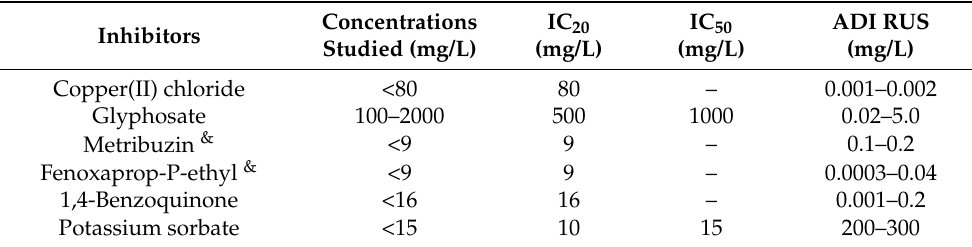
Table 1. IC 20 (mg/L) and IC 50 (mg/L) values determined from the effects of toxicants and food preservatives on trypsin-assay system * # .